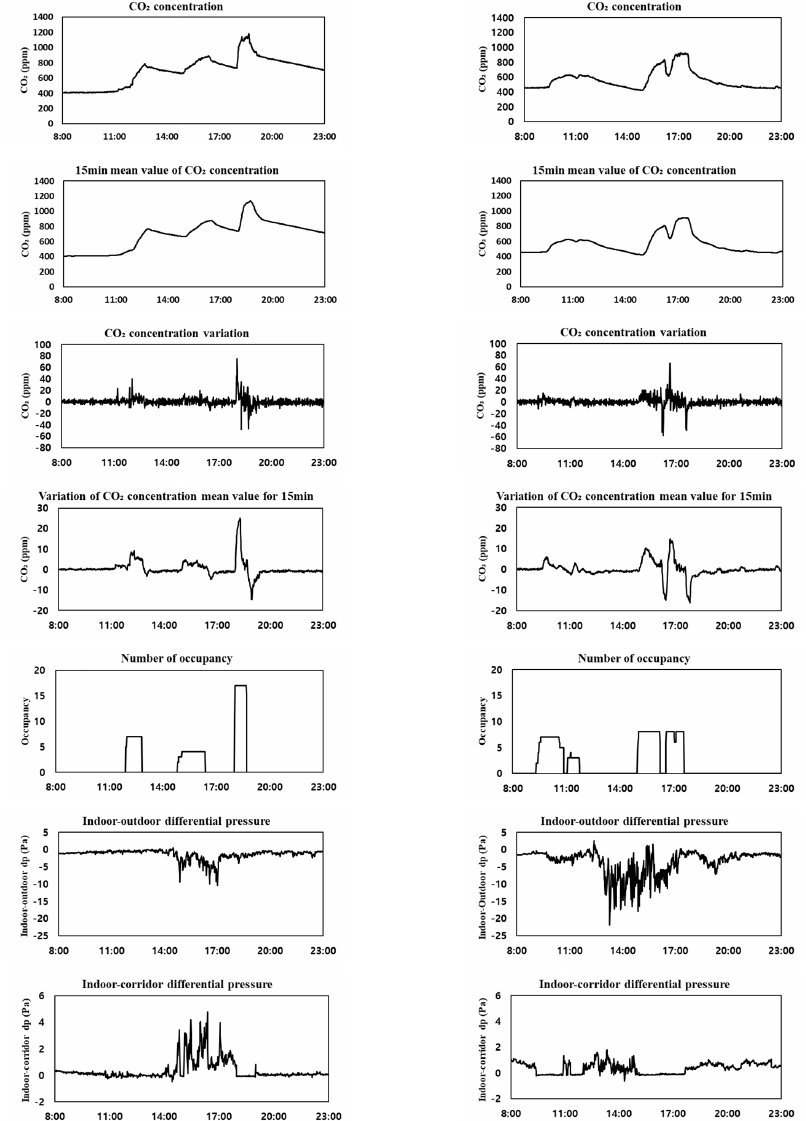
Figure 4. The ground truth data on ( a ) 11/7 and ( b ) 11/16.